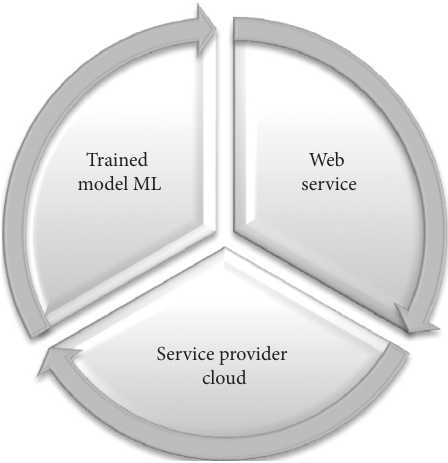
Figure 8: Components required in